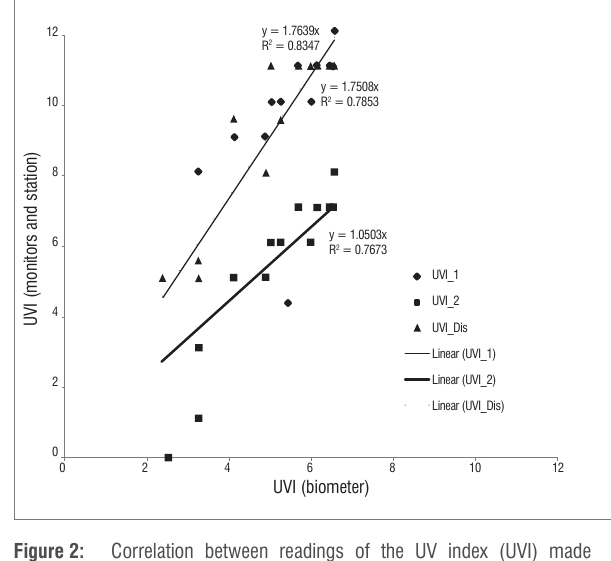
Figure 2: Correlation between readings of the UV index (UVI) made by two personal UVI monitors (UVI_1 and UVI_2) and a UVI display station (UVI_Dis) and the biometer of the South African Weather Service.